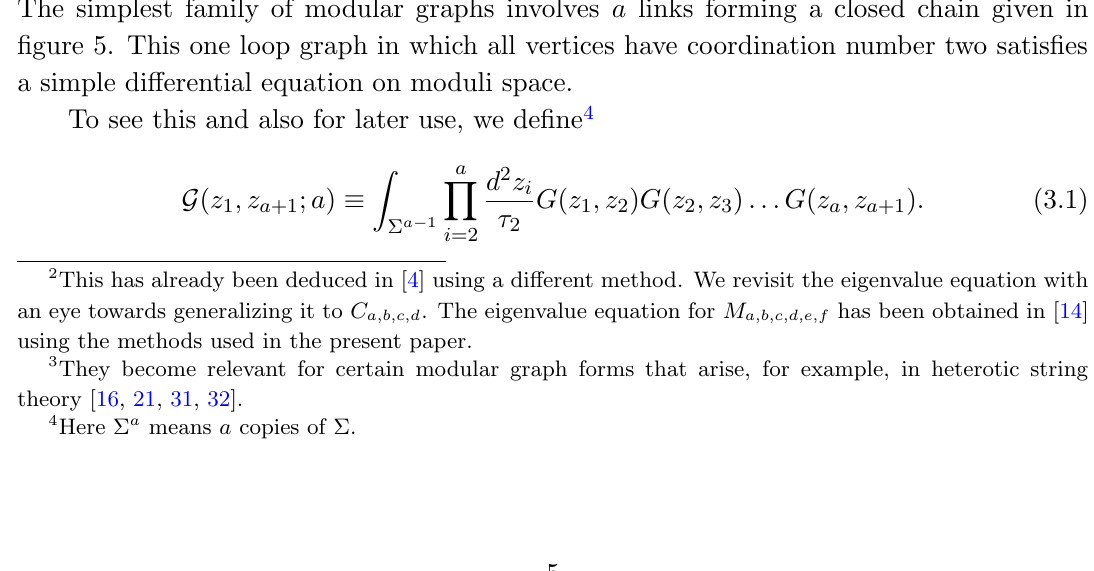
n @ m G ( z 1 ; z 2 z 1 z 2